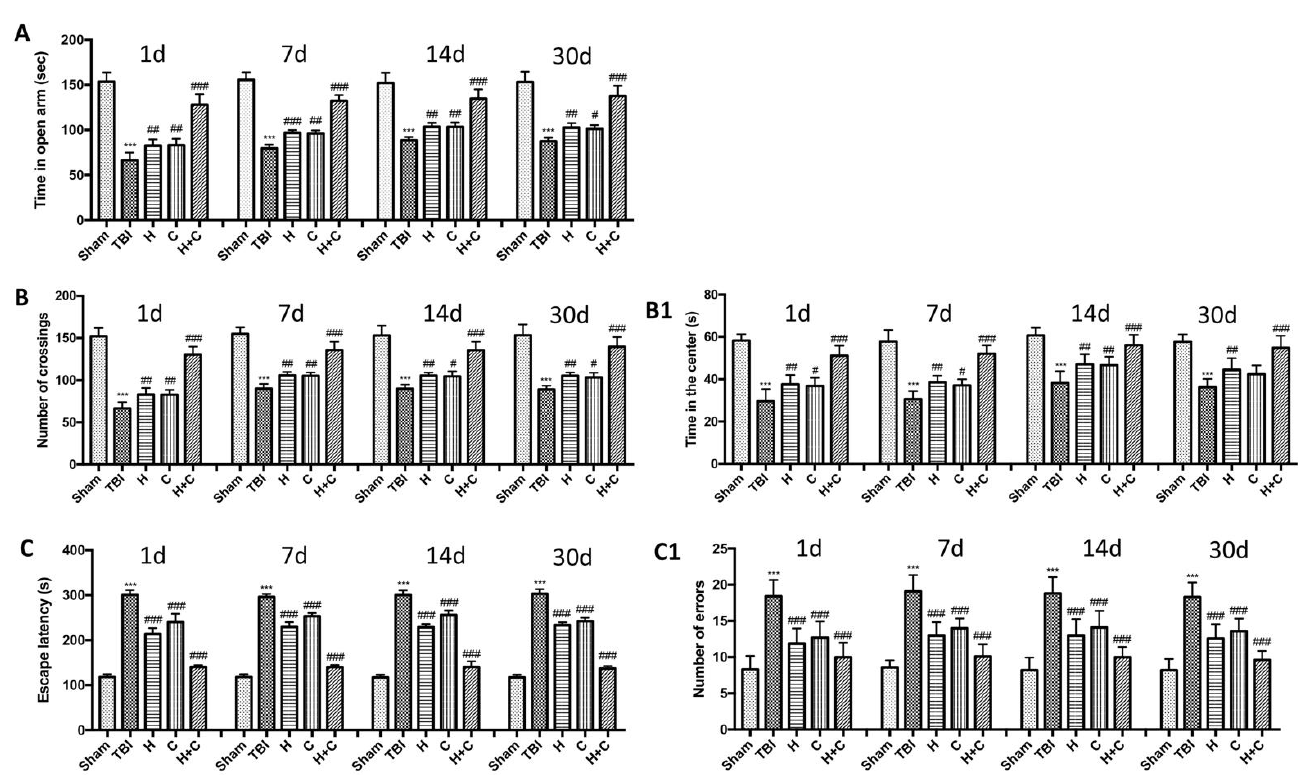
Figure 15. Effect of H. erinaceus or C. versicolor , or H. erinaceus + C. versicolor treatment on anxious behavior after chronic TBI. The degree of non-motor impairment was assessed blindly at different time points (1, 7, 14 and 30 days) and with different behavioral tests. Elevated plus maze (EPM) testing showed that TBI animals spent less time exploring open arms than Sham animals. While the animals treated with H, C and especially with H + C had a greater propensity to remain in the open arms ( A ). OF tests showed that TBI mice traveled significantly shorter distances and did not stay in the central area longer, unlike treated mice which instead moved longer distances ( B , B1 ). Barnes maze test revealed a decrease in TBI-induced spatial learning by increasing the latency for escape and mean number errors, which were reduced by all three treatments and in particular by the association ( C , C1 ). Data are means ± SEM of n = 10 mice/group. ( A ) *** p < 0.001 vs. Sham; # p < 0.05 vs.